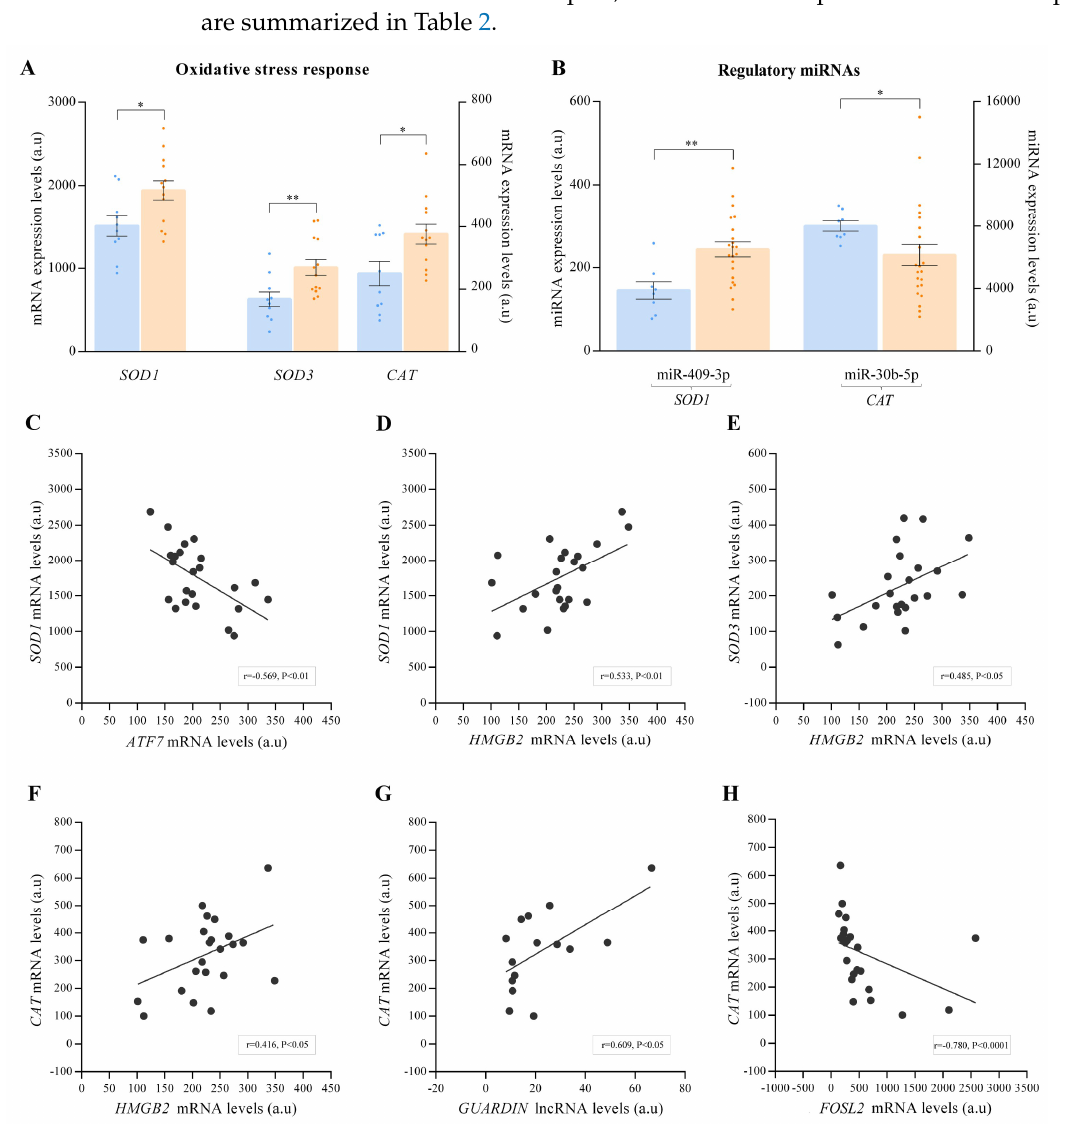
Figure 3. Dot plot graph of mRNA ( n = 23) and miRNA ( n = 30) expression levels of altered molecules associated with stress oxidative response. ( A ) mRNA relative expression levels of altered genes associated with stress oxidative response. ( B ) miRNAs target SOD1 and CAT . ( C ) Correlation of ATF7 mRNA levels with SOD1 mRNA levels. ( D ) Correlation of HMGB2 mRNA levels with SOD1 mRNA levels. ( E ) Correlation of HMGB2 mRNA levels with SOD3 mRNA levels. ( F ) Correlation of HMGB2 mRNA levels with CAT mRNA levels. ( G ) Correlation of GUARDIN mRNA levels with CAT mRNA levels. ( H ) Correlation of FOSL2 mRNA levels with CAT mRNA levels. The results were obtained by mRNA- sequencing SOLiD 5500XL platform and ncRNA-sequencing Illumina HiSeq 2500 platform. Data are presented as the mean ± SEM. au, arbitrary units. Ischemic cardiomyopathy patients (orange), controls subjects (blue). * p < 0.05, ** p <